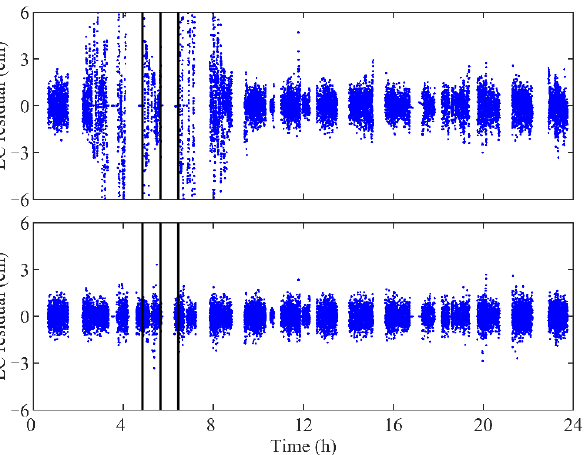
Figure 9. LC residuals of BDS2 ‐ based POD for TH ‐ 2A without maneuver estimation ( top panel ) and those with maneuver estimation ( bottom panel ) on DOY 314, 2019. The vertical bars denote the centers of thrust execution periods. Residuals beyond ±6 cm are not shown in the top panel.